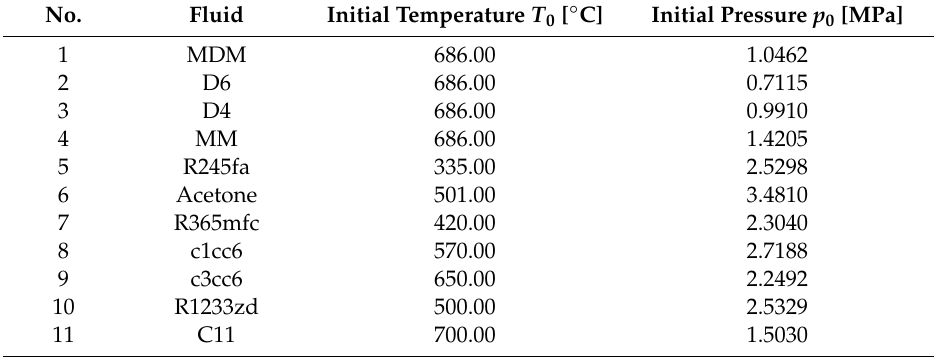
Table 2. Initial temperatures and pressures for di ff erent working media for cycle variant 2 (cycle with superheated live vapor and a regenerator for warming up, vaporization and partial superheating of the working